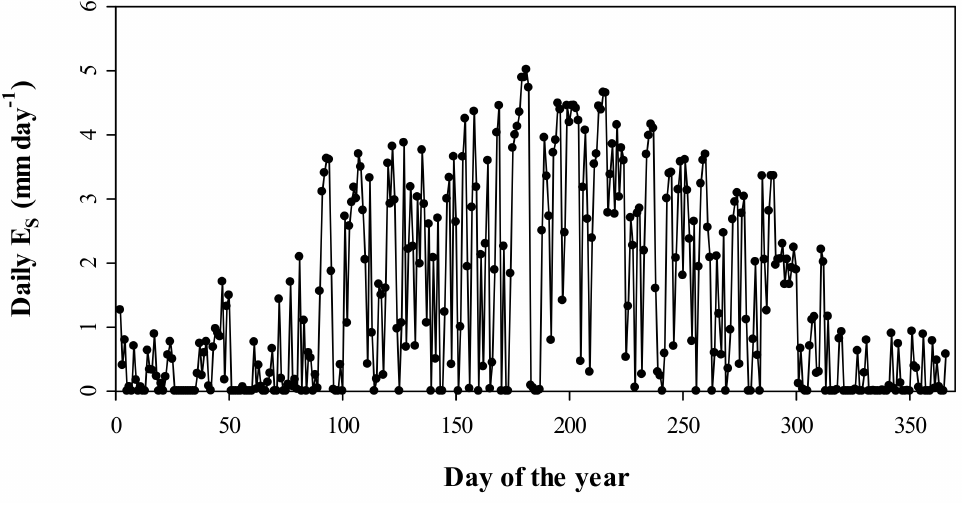
Figure 6. The variation of daily stand transpiration ( E s ) in